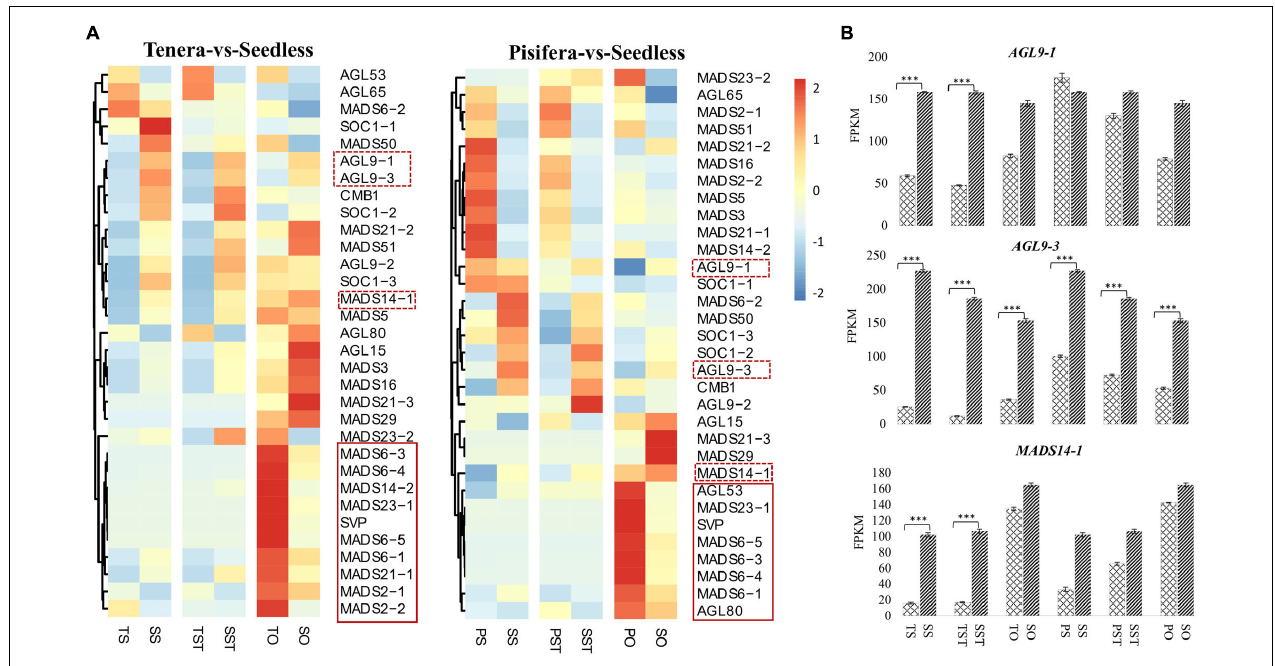
FIGURE 8 | Expression patterns of MADS-box genes. (A) Heatmap showing the expression patterns of MADS-box genes in Tenera-vs-Seedless and Pisifera-vs-Seedless. Red dotted boxes represent the genes that were highly expressed ( > 100 FPKM) in Seedless palm trees and showed increased expressions compared with Tenera and Pisifera. Red solid line boxes represent genes that were down-regulated in the ovary of Seedless palm trees compared with Tenera and Pisifera. (B) Expression patterns of highly expressed MADS-box genes. T, Tenera; P, Pisifera; S, Seedless; S, stigma; ST, style; O, ovary. Asterisks ( ∗∗∗ P ≤ 0.001) indicate a significant difference according to the Student’s t